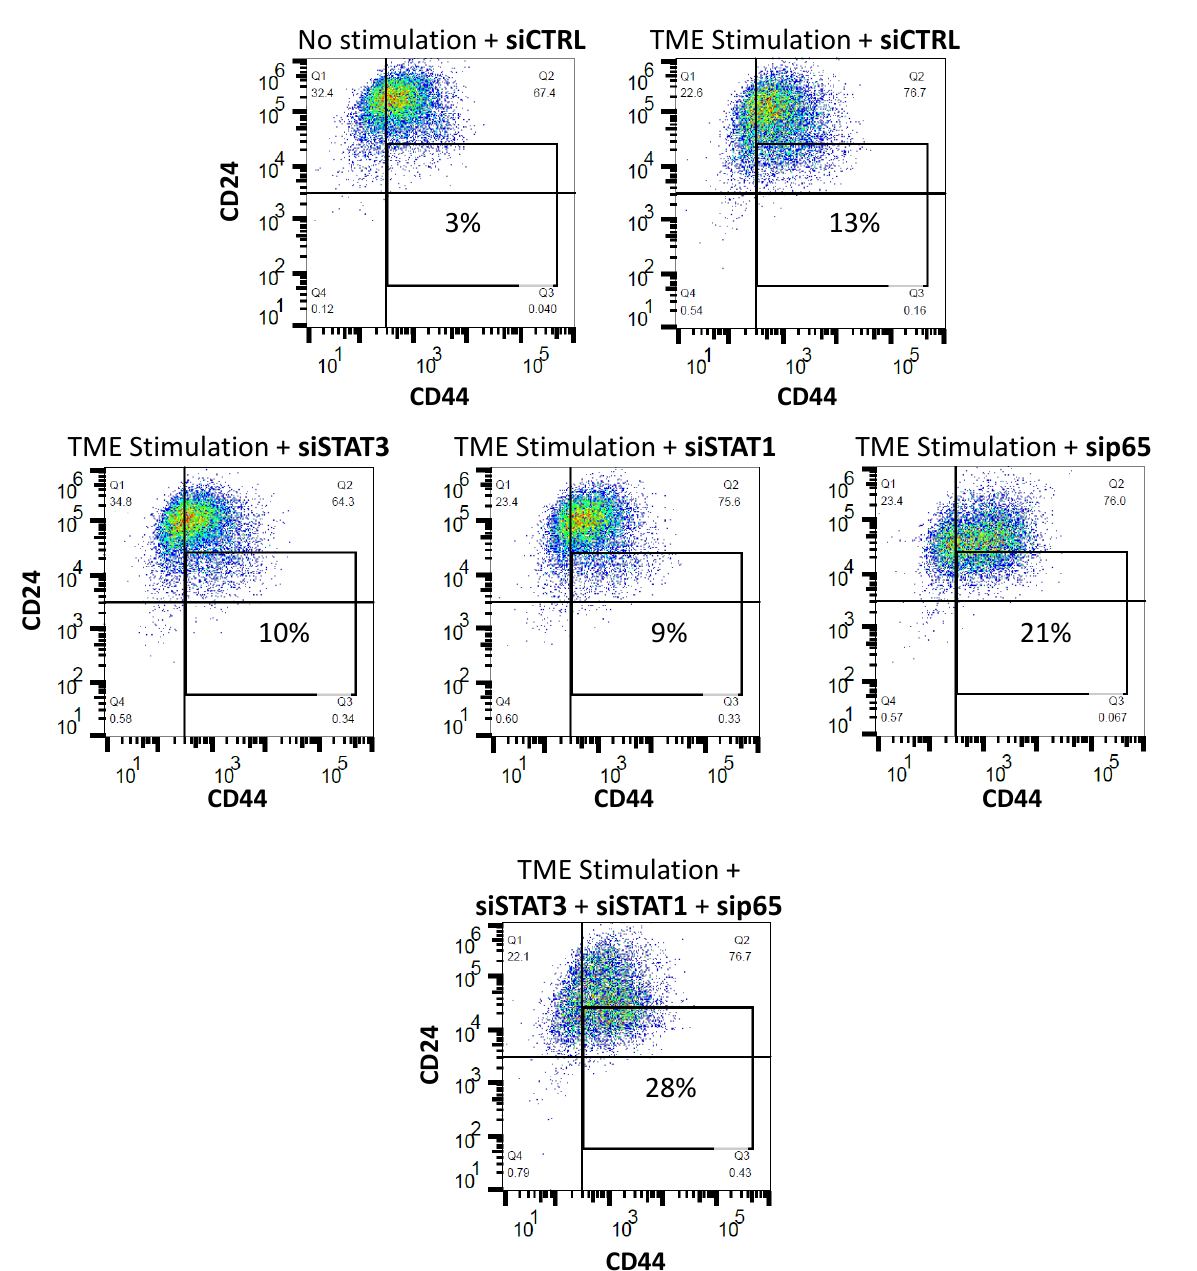
Figure 11. Upon TME Stimulation, knock-down of p65 and STAT3 together leads to further increased CSC enrichment in HR+/HER2 − breast cancer cells: MCF-7 cells were transfected with siSTAT3, siS- TAT1 and/or sip65 (or siCTRL), as described above. The cells were then exposed to TME Stimulation (concentrations as described in Figure 1) for 96 h or treated by vehicle control (“No stimulation”). The contents of CSCs were determined as described in Figure 1. The results are from a representative experiment of n = 3, showing similar